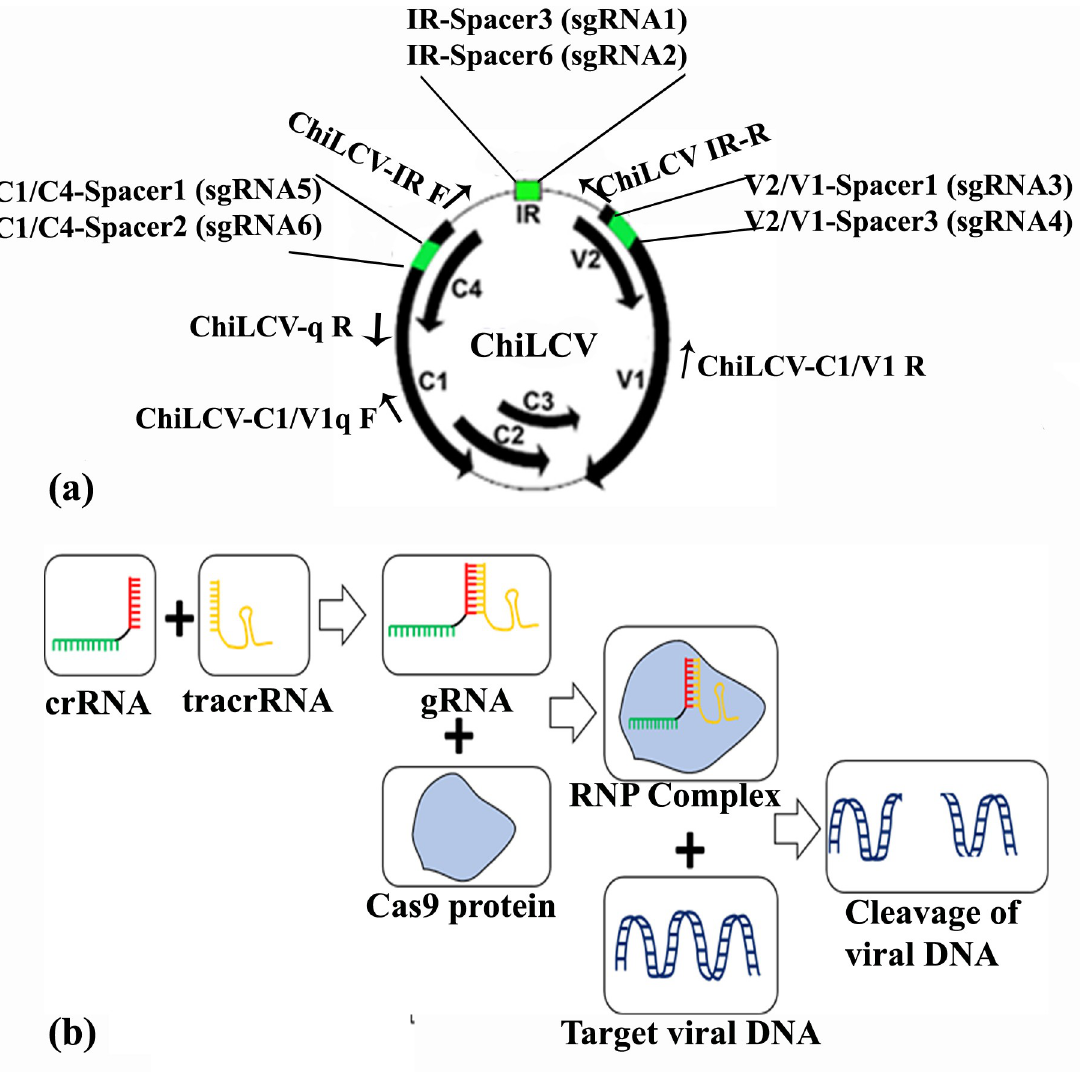
Fig 1. Position of different primers and spacer sequence in the chilli leaf curl virus (ChiLCV) genome and plan for in vitro cleavage assay. a) Three genomic regions (green color) of the ChiLCV were selected to identify the spacer, including i. Intergenic region (IR) with the origin of replication, ii. Overlapping regions between V2 and V1 genes (V2/V1) and iii. Overlapping regions between C1 and C4 genes (C1/C4); b) schematic representation of in vitro cleavage